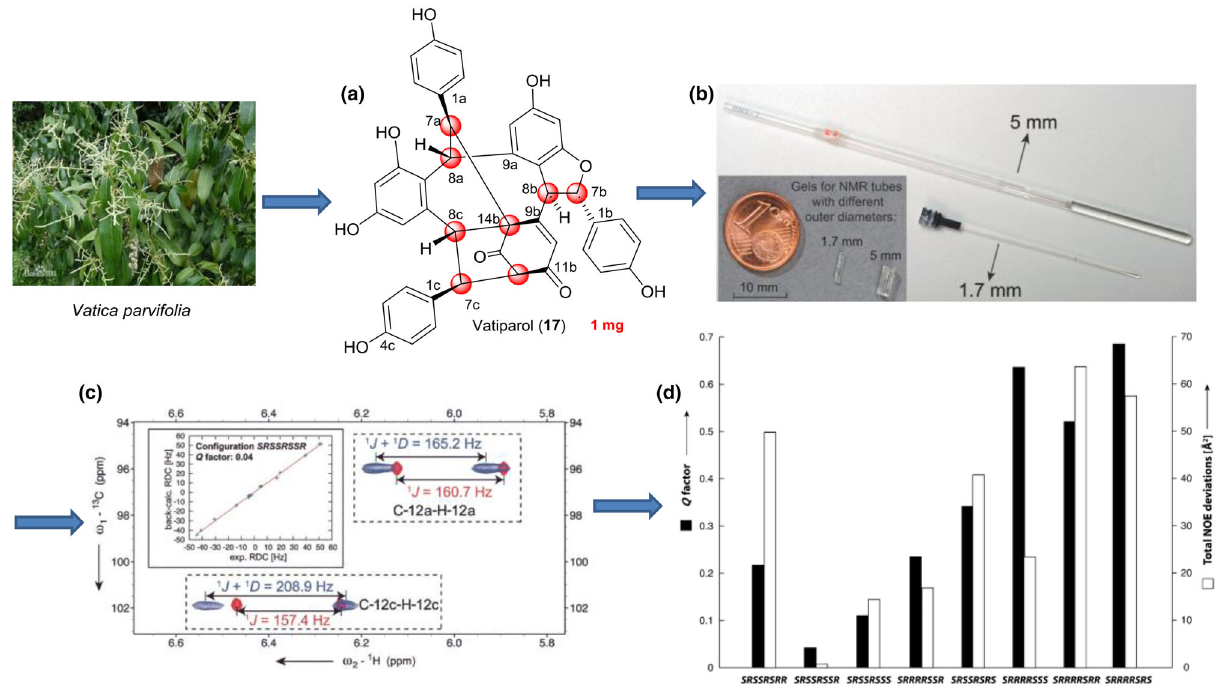
the splitting between isotopic and anisotropic signals. ( d ) Comparison of Q factors of eight possible diastereomers by NOE deviations and RDC fitting